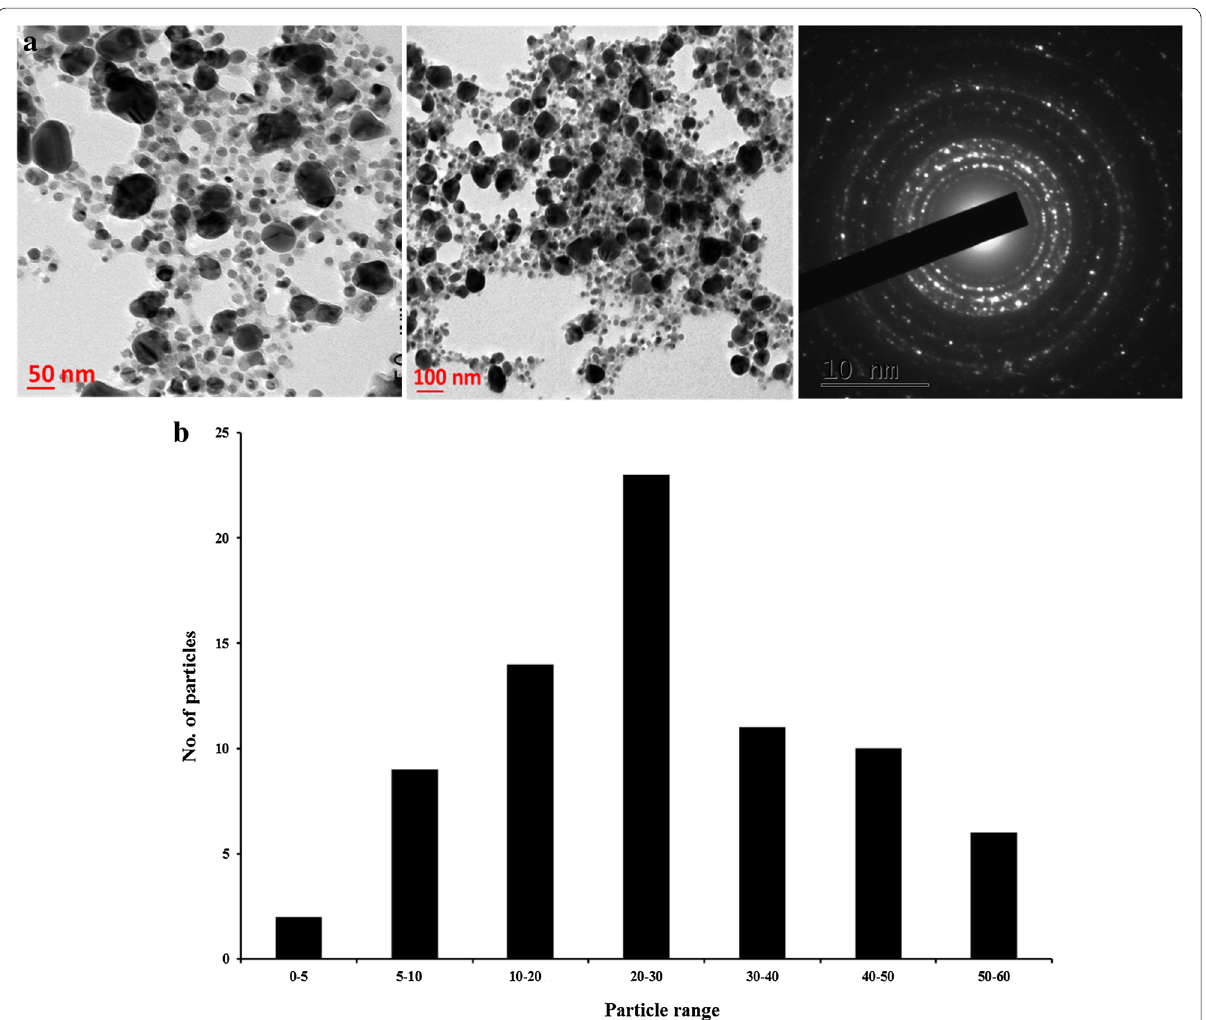
Fig. 5 a TEM micrograph showing size of silver nanoparticles at 50 and100 nm scales and SAED pattern. b Particle size histogram of